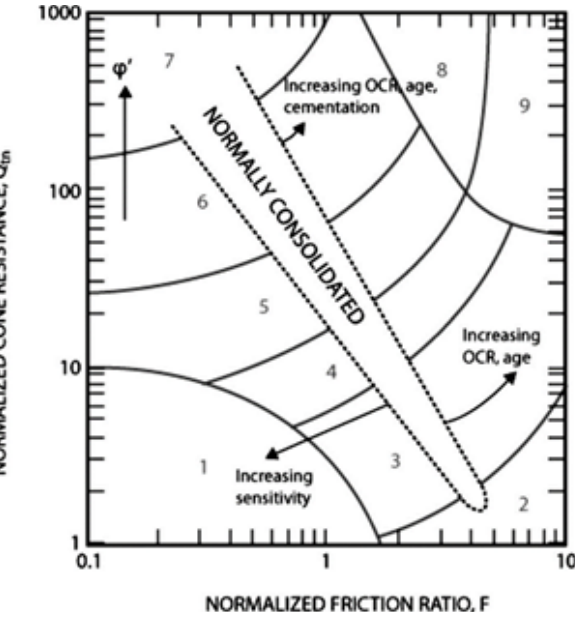
thresholds showed on Roberson’s soil behaviour Figure 3: The I c type classification chart